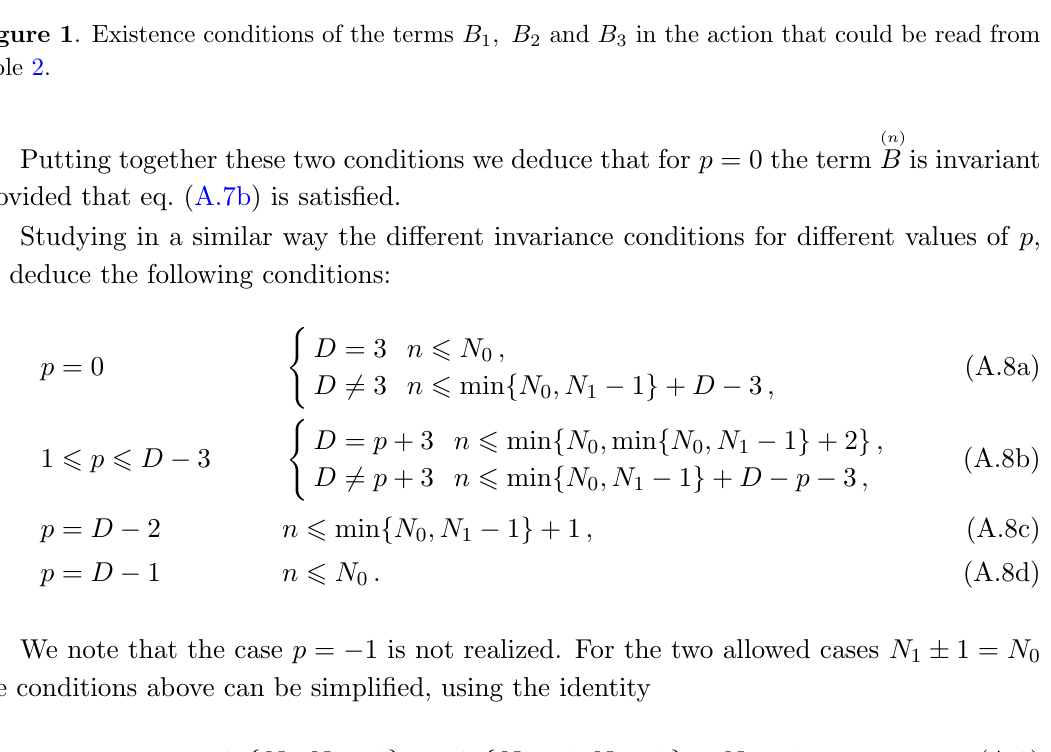
1 ; B 2 and B 3 in the action that could be read from